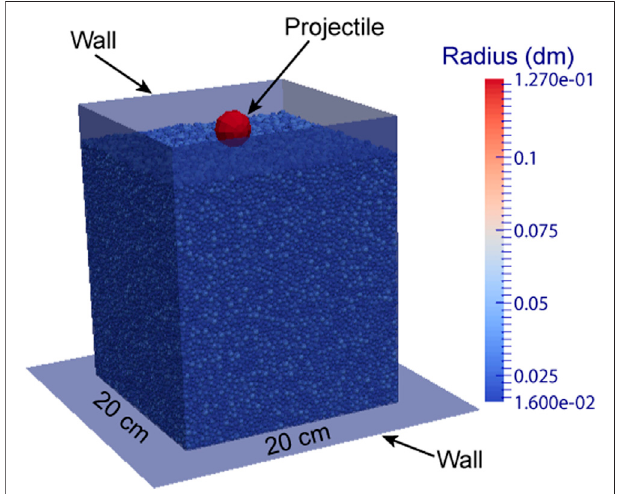
FIGURE2| Numericalmodelcon fi gurations.Particlesarecoloredonthe basis of their